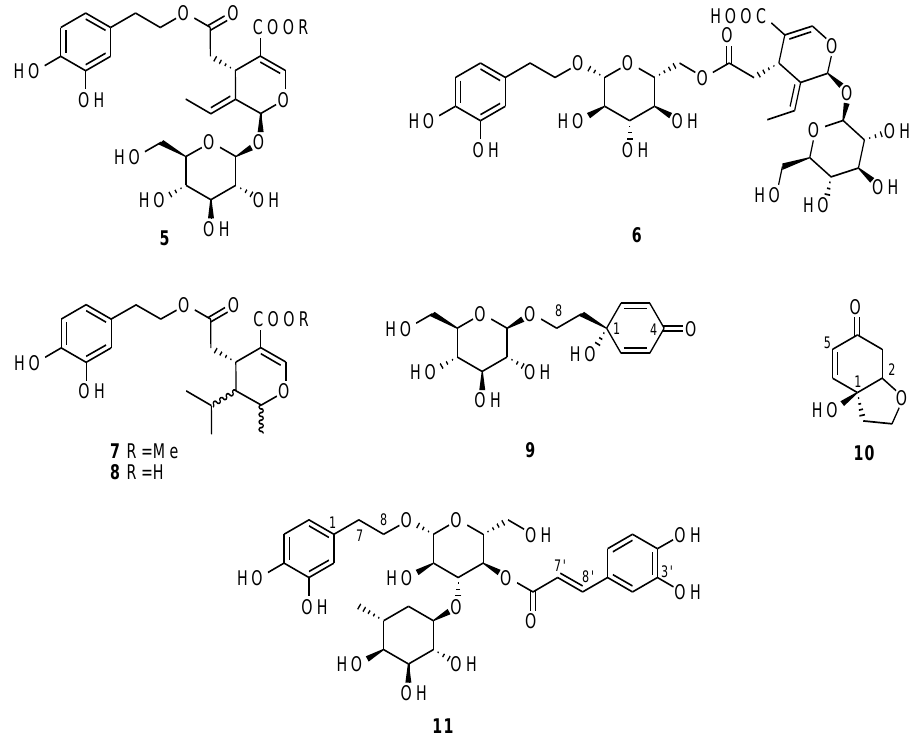
Figure 8. Compounds 5 – 11 identified in the extracts and responsible for the differentiation of the samples.